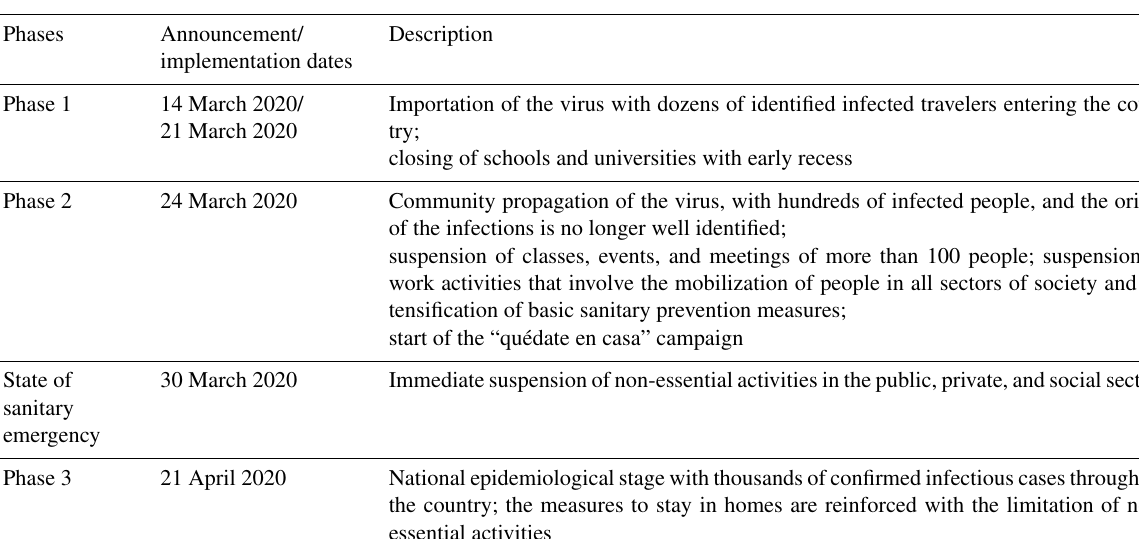
Table 1. Descriptions of the early phases of the federal lockdown in Mexico (Secretaría de Salud, 2020a).